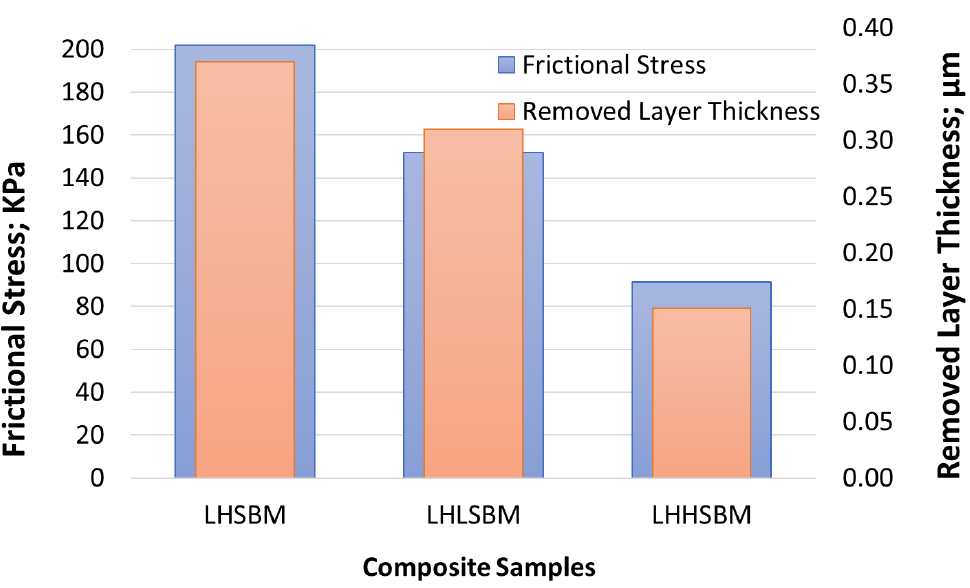
Figure 20. Frictional stress and wear layer thickness on the surface of the Al/SiC composites.